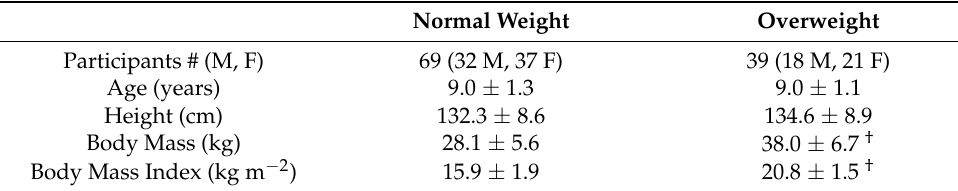
Table 1. Demographic and anthropometric characteristics of participants. Values are expressed as mean ±